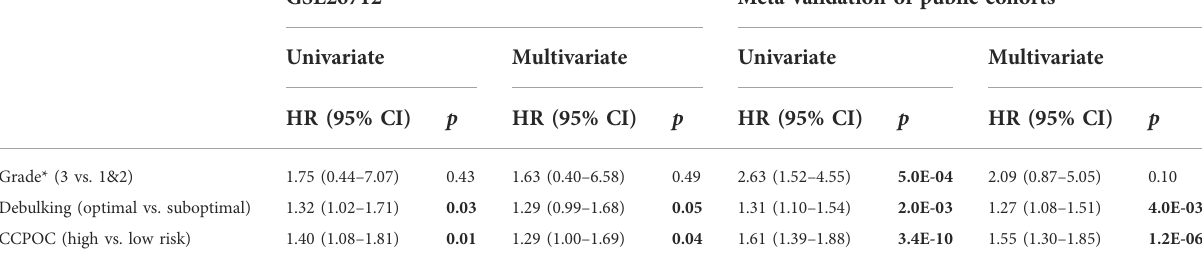
TABLE 2 Univariate and multivariate prognostic analyses of the cell cycle signature and clinicopathological factors in the training cohort and meta- validation of public